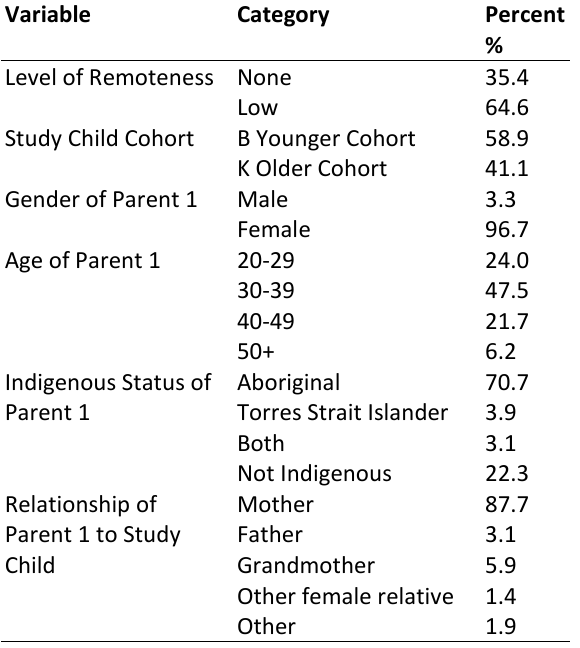
Table 1. Study child and parent 1 demographic details: LSIC Wave 6 (n=973).